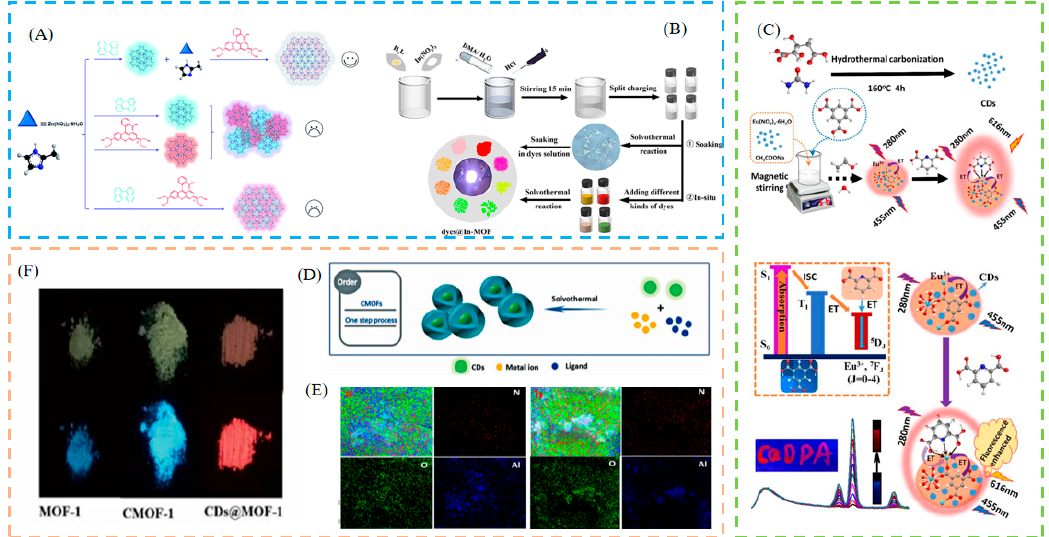
Figure 3. ( A ) Schematic description of the fabrication process of ZIF-8@dye@ZIF-8@dye. ( B ) Sche- matic description of the fabrication process of single-phase dyes@In-MOF. ( C ) Schematic descrip- tion of the fabrication process of carbon dots (CDs)-chelated Eu 3+ @metal–organic framework (Eu- MOFs). ( D ) Schematic illustration of growth mechanism for CMOF-1 and CDs@MOF-1. ( E ) Sche- matic description of mapping images of the CMOF-1 (a) and CMOF-2 (b). ( F ) Photographs of sam- ples exposed to sunlight (up) and under UV light (bottom). Reproduced with permission from [60–